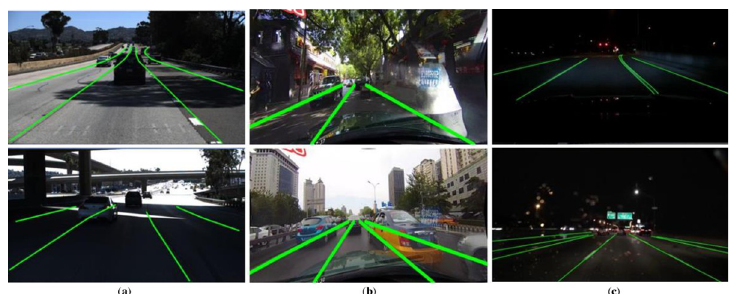
Fig 7. Examples of three datasets. ( a ) TuSimple dataset; ( b ) CuLane dataset; ( c ) BDD100K dataset.